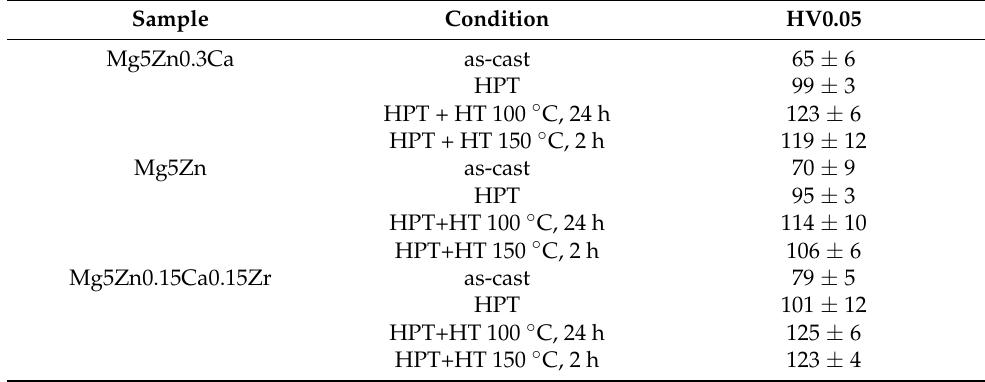
Table 2. Microhardness values of all investigated alloys in all conditions. HPT has been performed at 285 ◦ C.